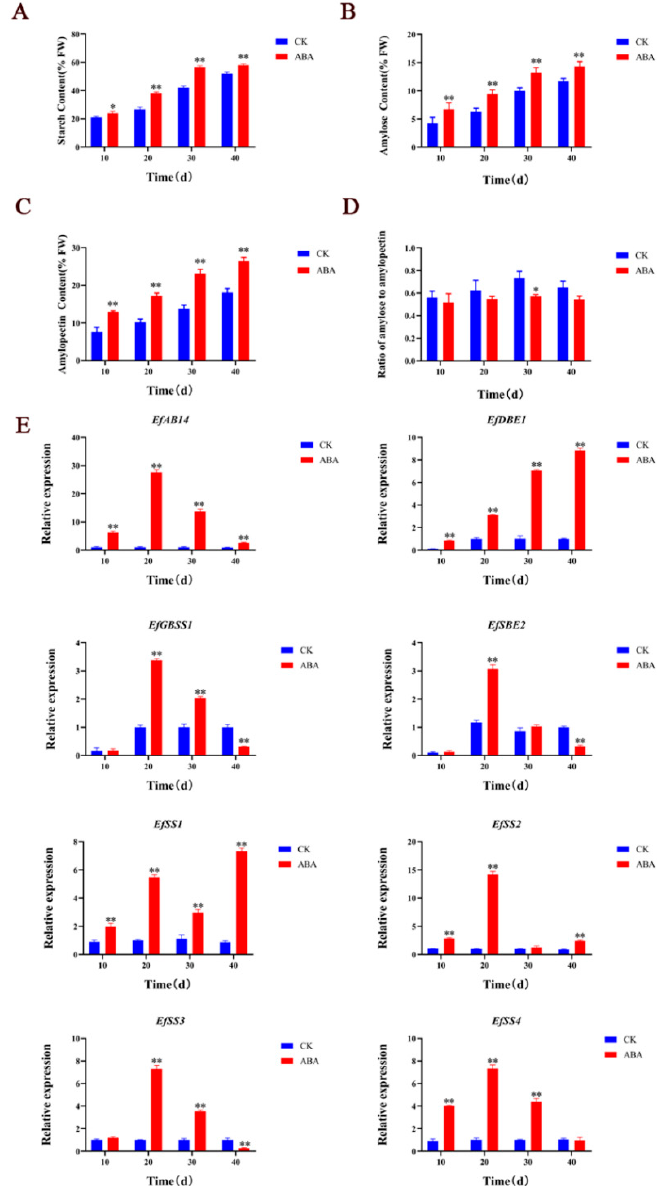
Figure 3. ( A ): The effects of ABA on total starch content in E. ferox seeds. ( B ): Effects of ABA on amylose synthesis in E. ferox seeds. ( C ): Effects of ABA on amylopectin synthesis in E. ferox seeds. ( D ): Effect of ABA on amylose to amylopectin ratio in E. ferox seeds. ( E ): The relative expression levels of EfABI4, EfDBE1, EfGBSS1, EfSBE2, EfSS1, EfSS2, EfSS3 and EfSS4 after ABA treatment during Euryale ferox Salisb development. The ‘*’ or ‘**’ above the histogram indicated the statistical significance at the level of 0.05 or 0.01 ( p < 0.05; p < 0.01).